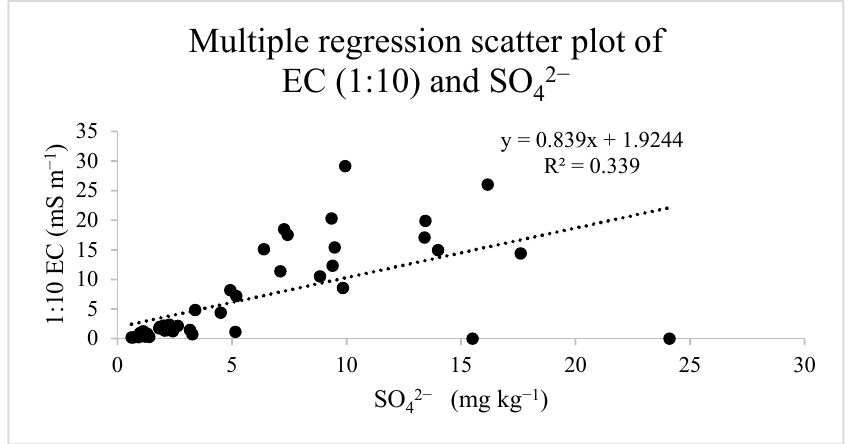
Figure 9. Multiple regression scatter plot between 1:10 ECBI and SO 42 − (BI = before incubation). 1:10 EC = 1:10 electronic conductivity; SO 42 − = Sulfate .